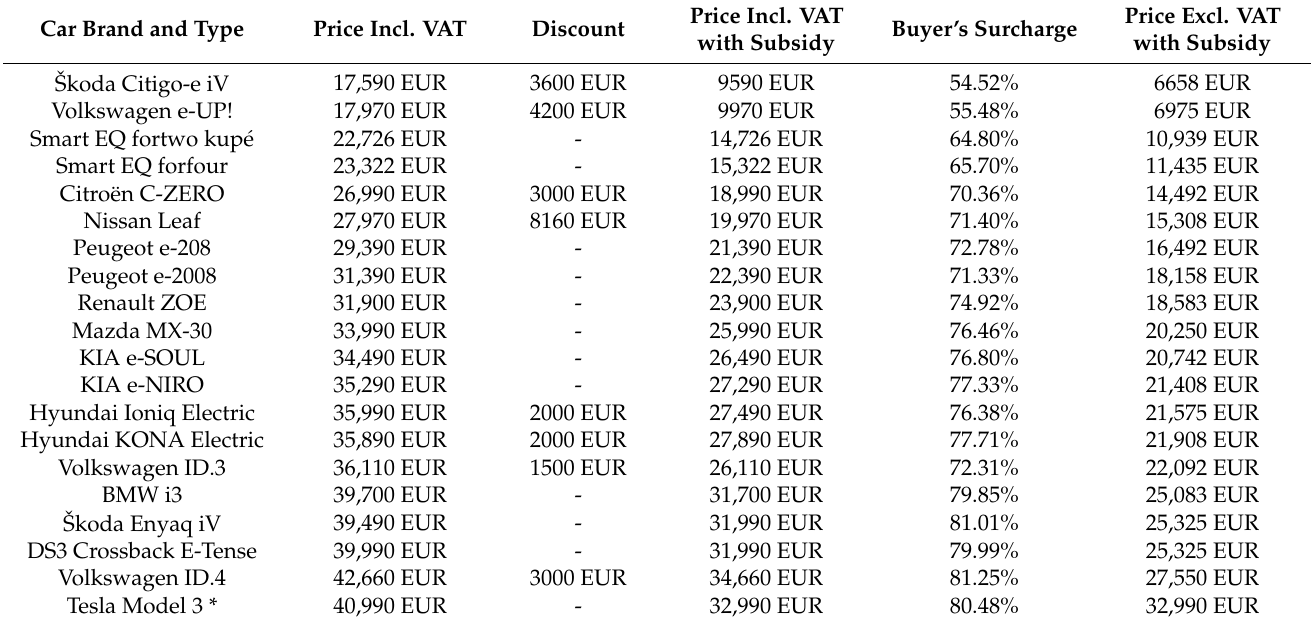
Table 9. Overview of BEV prices and buyers’ surcharges in Slovakia